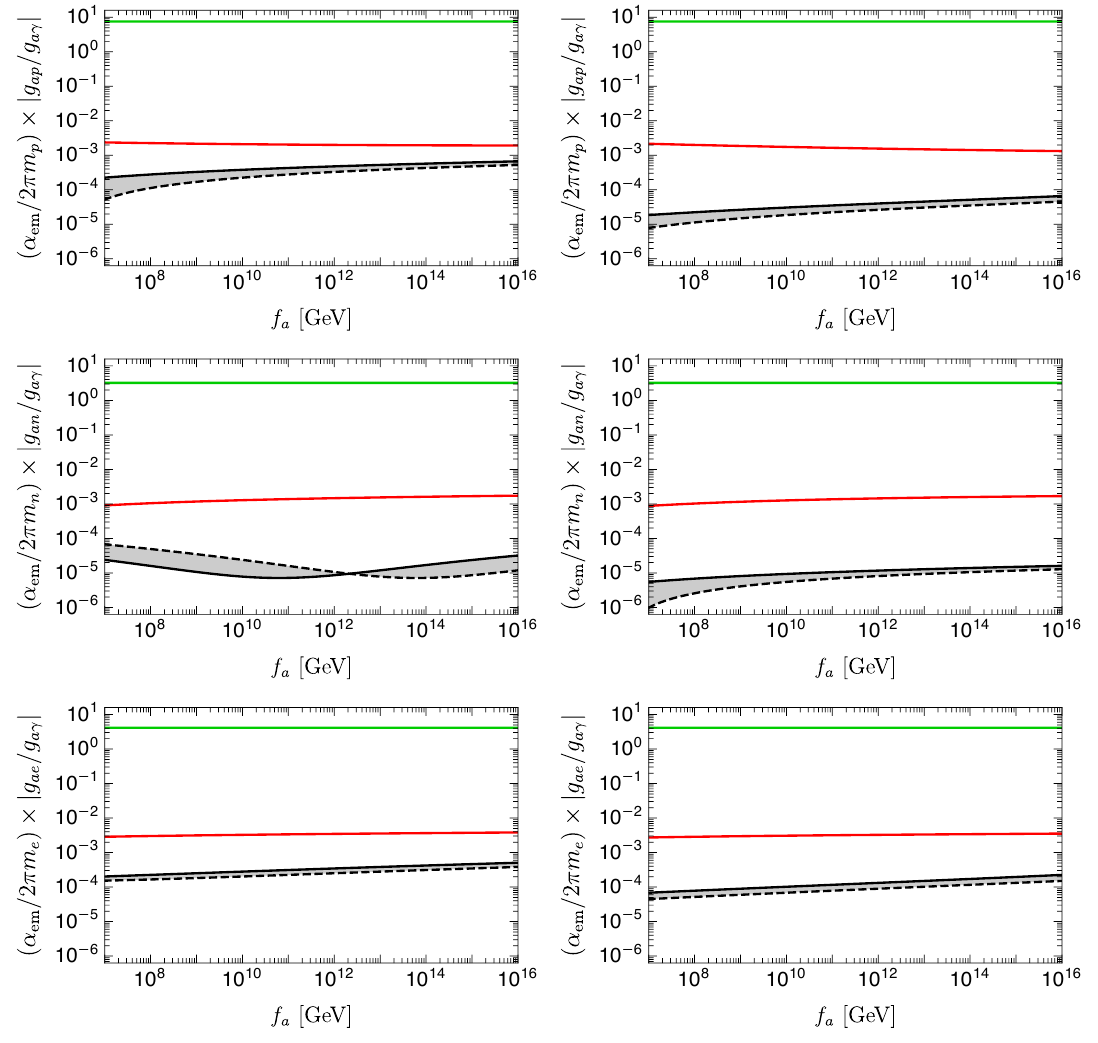
Figure 6 . The predicted ratios of the ALP couplings from the minimal axion models with c W = 1 ( c G = c B = 0) (left) and c B = 1 ( c G = c W = 0) (right) within the MSSM framework (green: DFSZ-like axions, black: KSVZ-like axions, red: string-theoretic axions). For KSVZ-like axions, the heavy color-singlet exotic fermion charged under SU(2) L (left) or U(1) Y (right) is assumed to have a mass between 10 − 3 f a (dashed black) and f a (solid black). For the MSSM parameters, we take tan β = 10 and m SUSY = 10